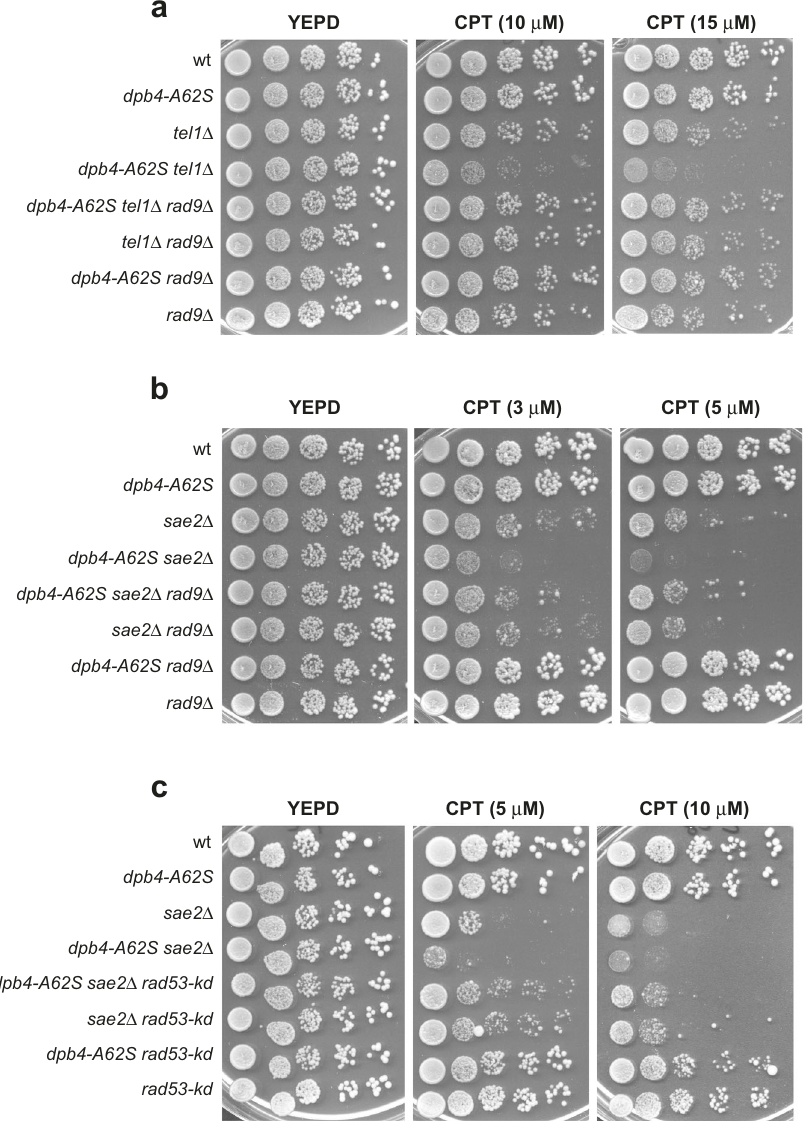
Fig. 4 Dpb4-A62S increases the DNA damage sensitivity of tel1 Δ and sae2 Δ cells in a Rad9- and Rad53-dependent manner. a – c Exponentially growing cultures with the indicated genotypes were serially diluted (1:10) and each dilution was spotted out onto YEPD plates with or without